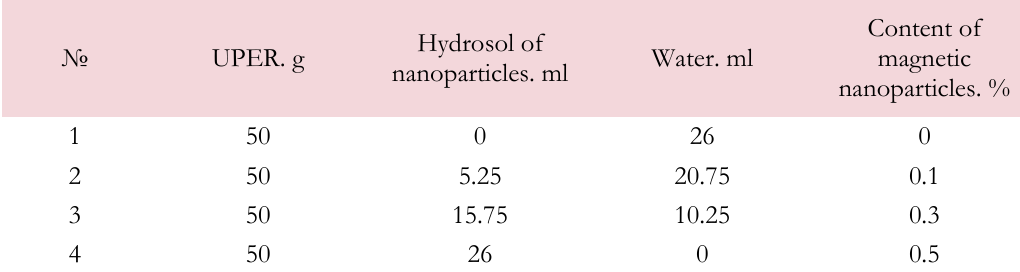
Table 1: Content of the used magnetic